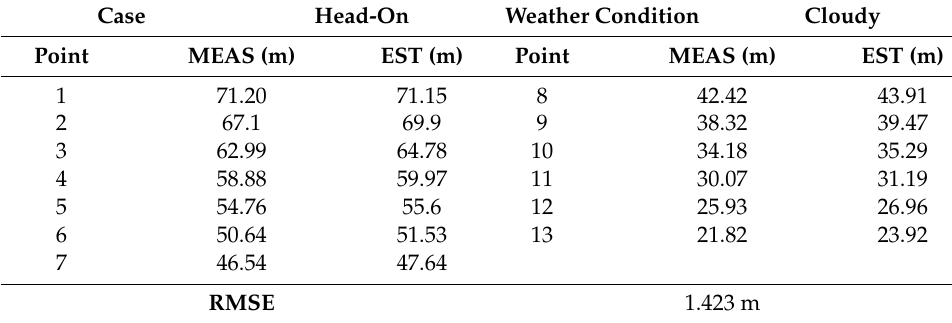
Figure 31. Result of model evaluation in Experiment 4. Table 9. Experiment 4 (estimation vs. GPS